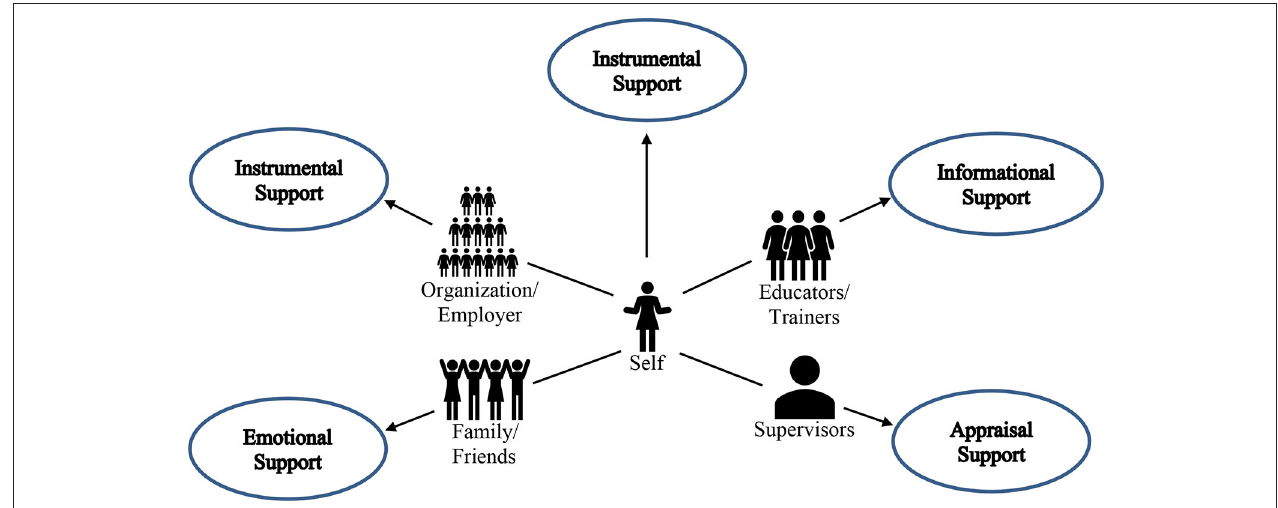
FIGURE 1 | Women’s social support network for career